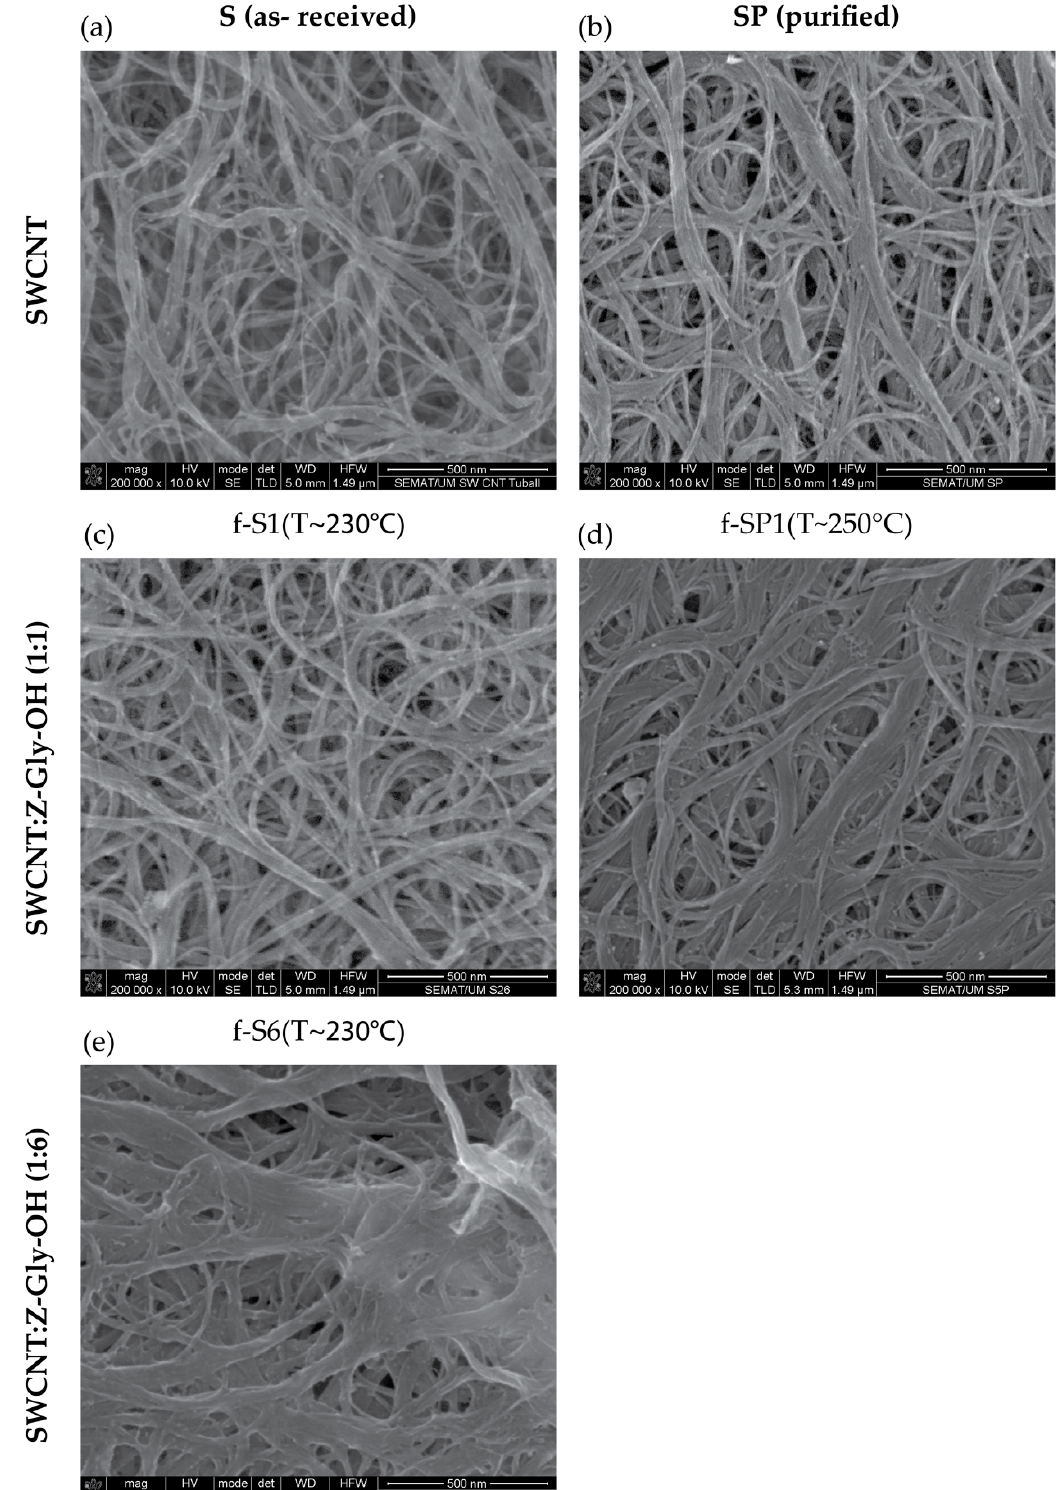
Figure 2. SEM micrographs of the ( a ) pristine, ( b ) purified, and ( c – e ) functionalized SWCNT.